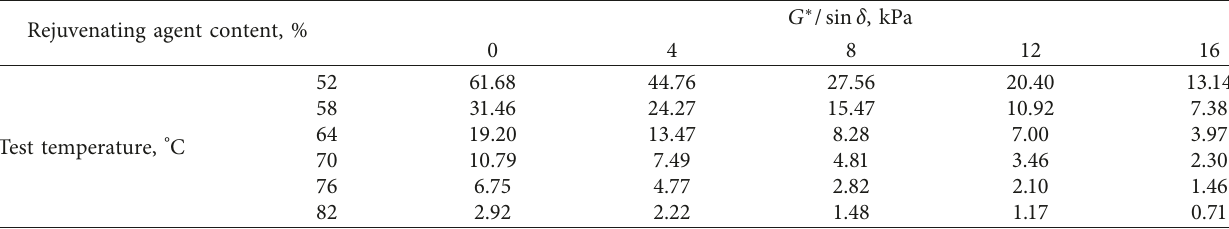
Table 10: Test results of G ∗ / sin δ after RTFOT.